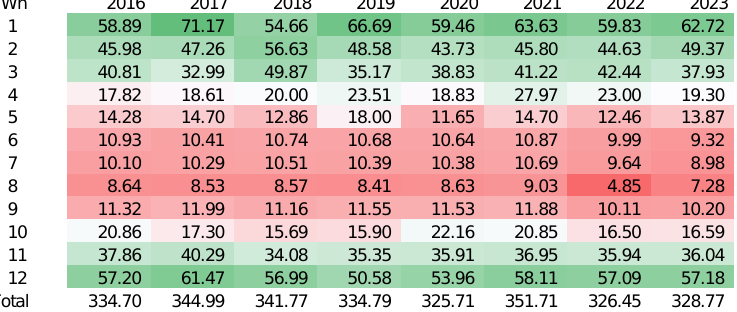
Figure 10. Neutral forecast of natural gas supply to distribution area for 2024. Forecast exercised for the period September 2022 to December 2023. These data can be found here: https://www.ec.europa.eu/ (accessed on 20 March 2022). Funding: This research received no external funding .